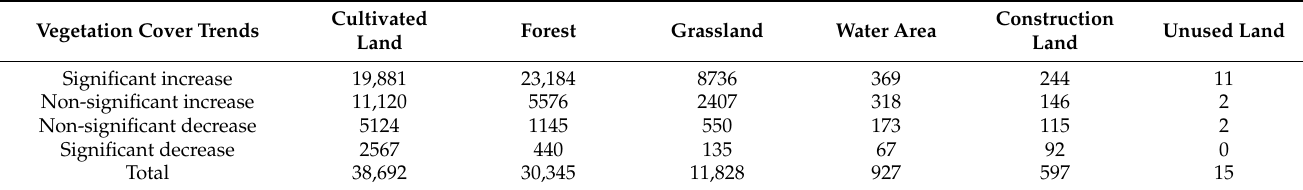
Figure A3. Distribution of vegetation cover under the influence of human activities. ( a ) 2000, ( b ) 2020. Table A1. Quantitative status of land use types in 2000 in different regions.